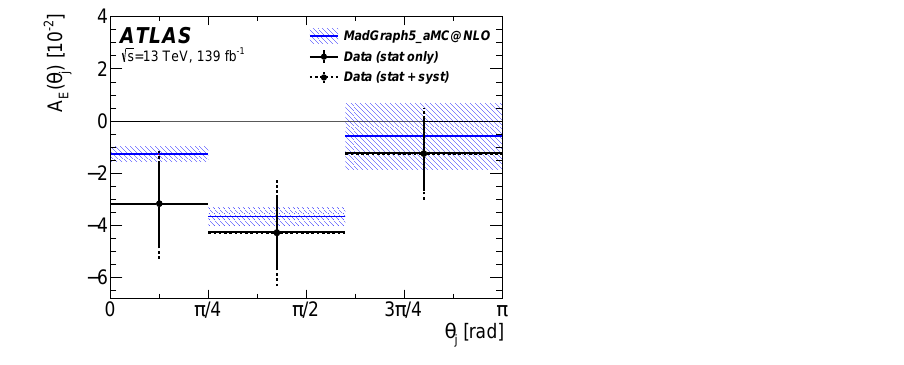
Figure 28. Measured energy asymmetry (black points) in three bins of the jet angle θ j , compared to the prediction from simulation (blue lines) [69].